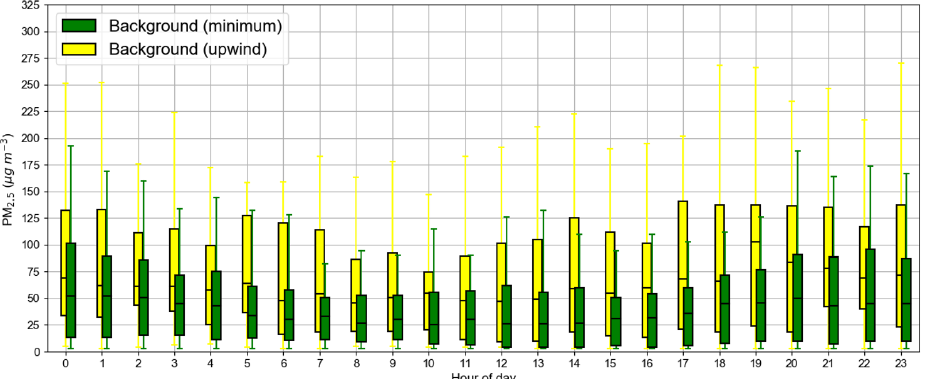
Figure 14. Ranges in campaign period mean calculated background PM 2 . 5 concentrations for each hour of the day using minimum (green) and upwind (yellow) concentration